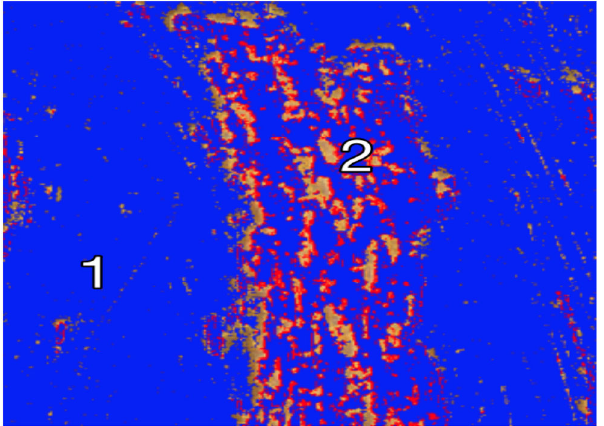
Fig. 11 Highlighted optical micrograph of wear track of sample CpC5 showing minor polishing and major erosion along the wear